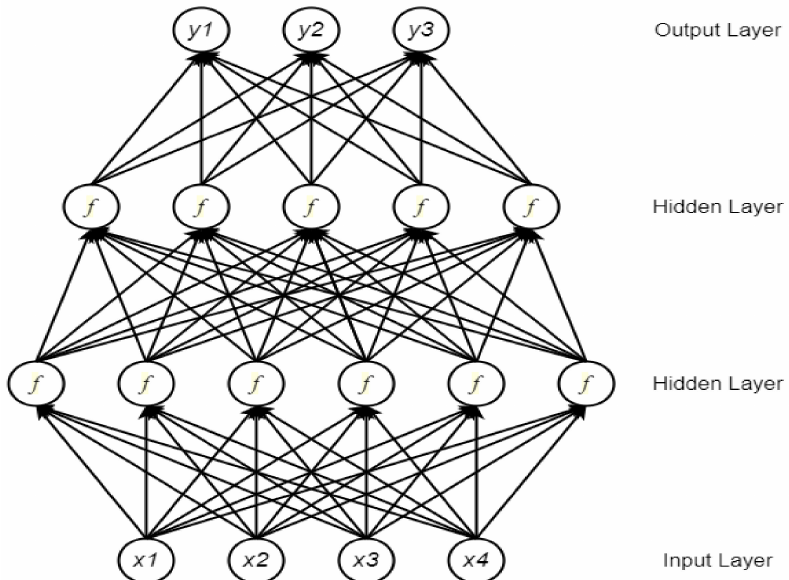
Figure 1. A neural network (NN) with four inputs and two hidden layers (adopted from [32]). x i represents an input feature for the network, and y i represents an output class